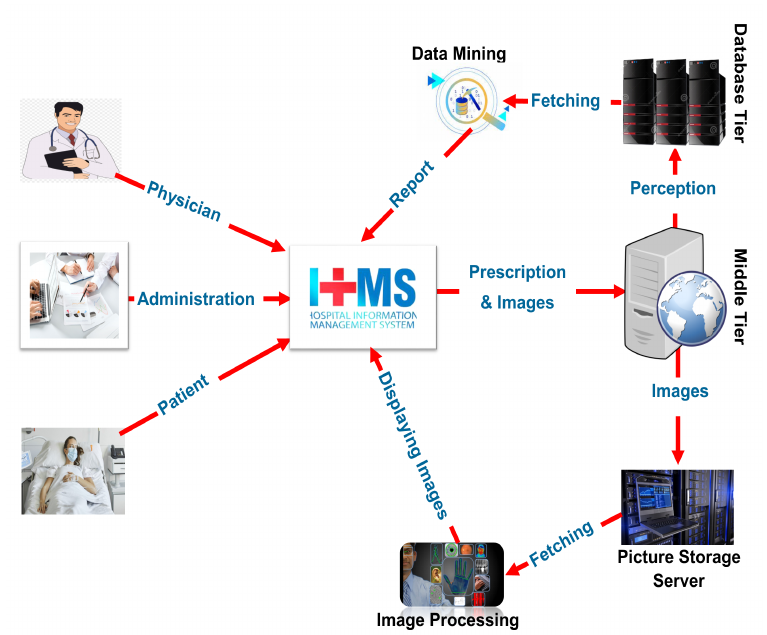
Figure 1. Workflow of proposed hospital information management system